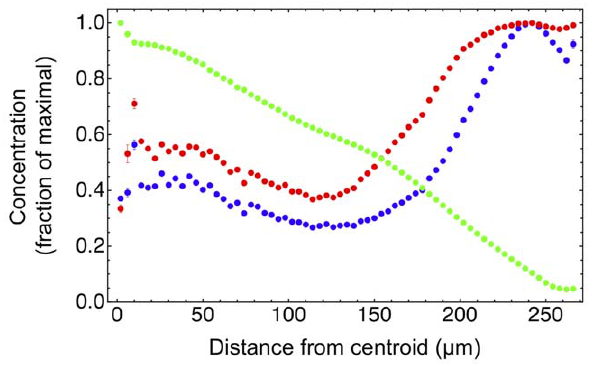
Figure 6. Plots of the normalized average intracellular concentration of lactate (green), glucose (blue), and ATP (red). These plots have been obtained in the same simulation and at the same time step as the plots of figure 5, and each concentration is normalized to its peak value. These plots indicate that cell death in the central region is due both to the accumulation of metabolites (lactate) and to metabolic stress (starvation).